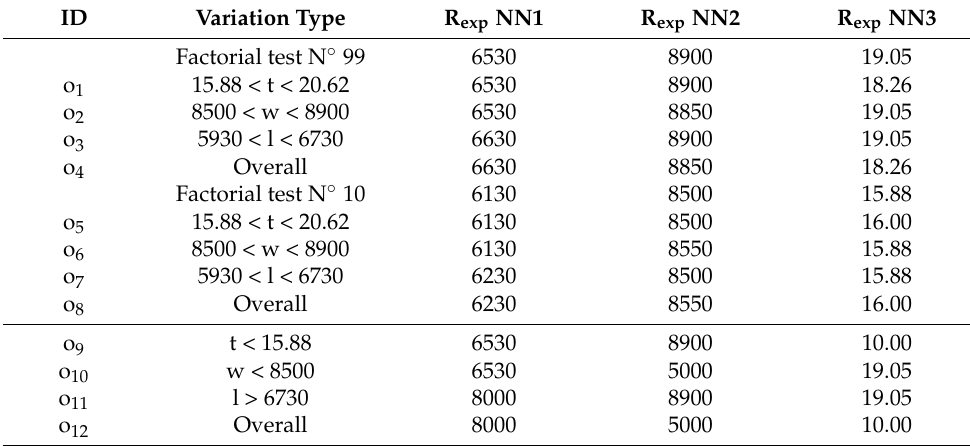
Table 4. Tests for generalization capacity of the neural network.